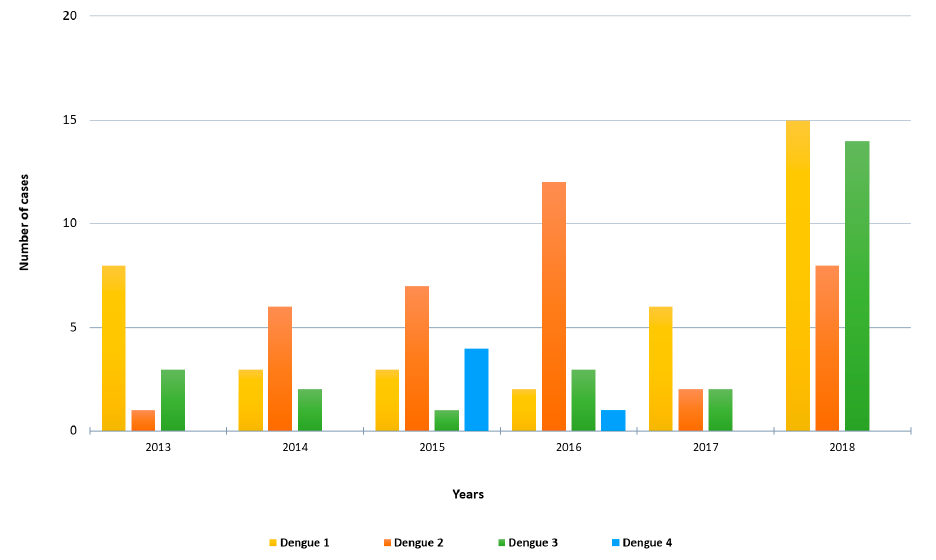
Figure 1. Number of imported RT-PCR-positive dengue cases by year and DENV serotype included in the study.